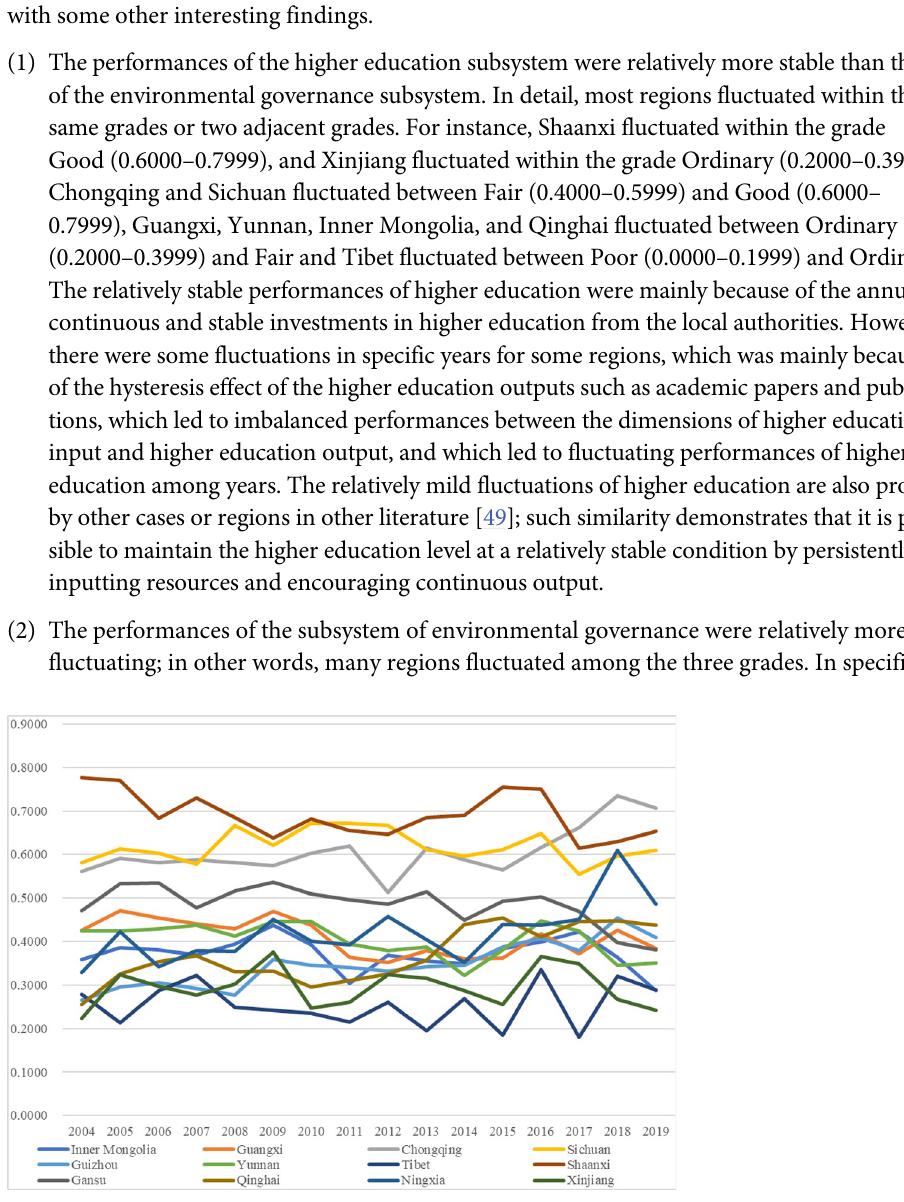
Fig 3. Performance of the higher education